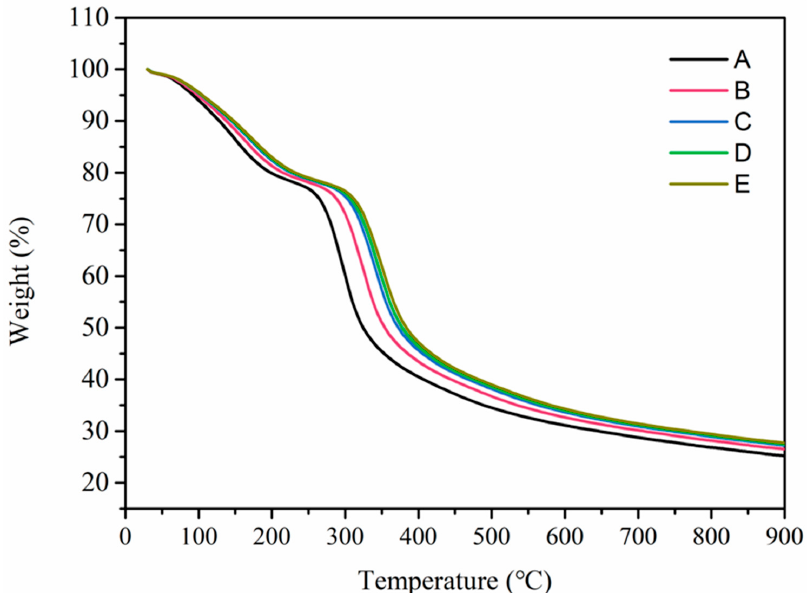
Figure 7. TG curves of hybrid aerogel with different doping amounts (A: 5%, B: 10%, C: 15%, D: 20%, E: 25%).